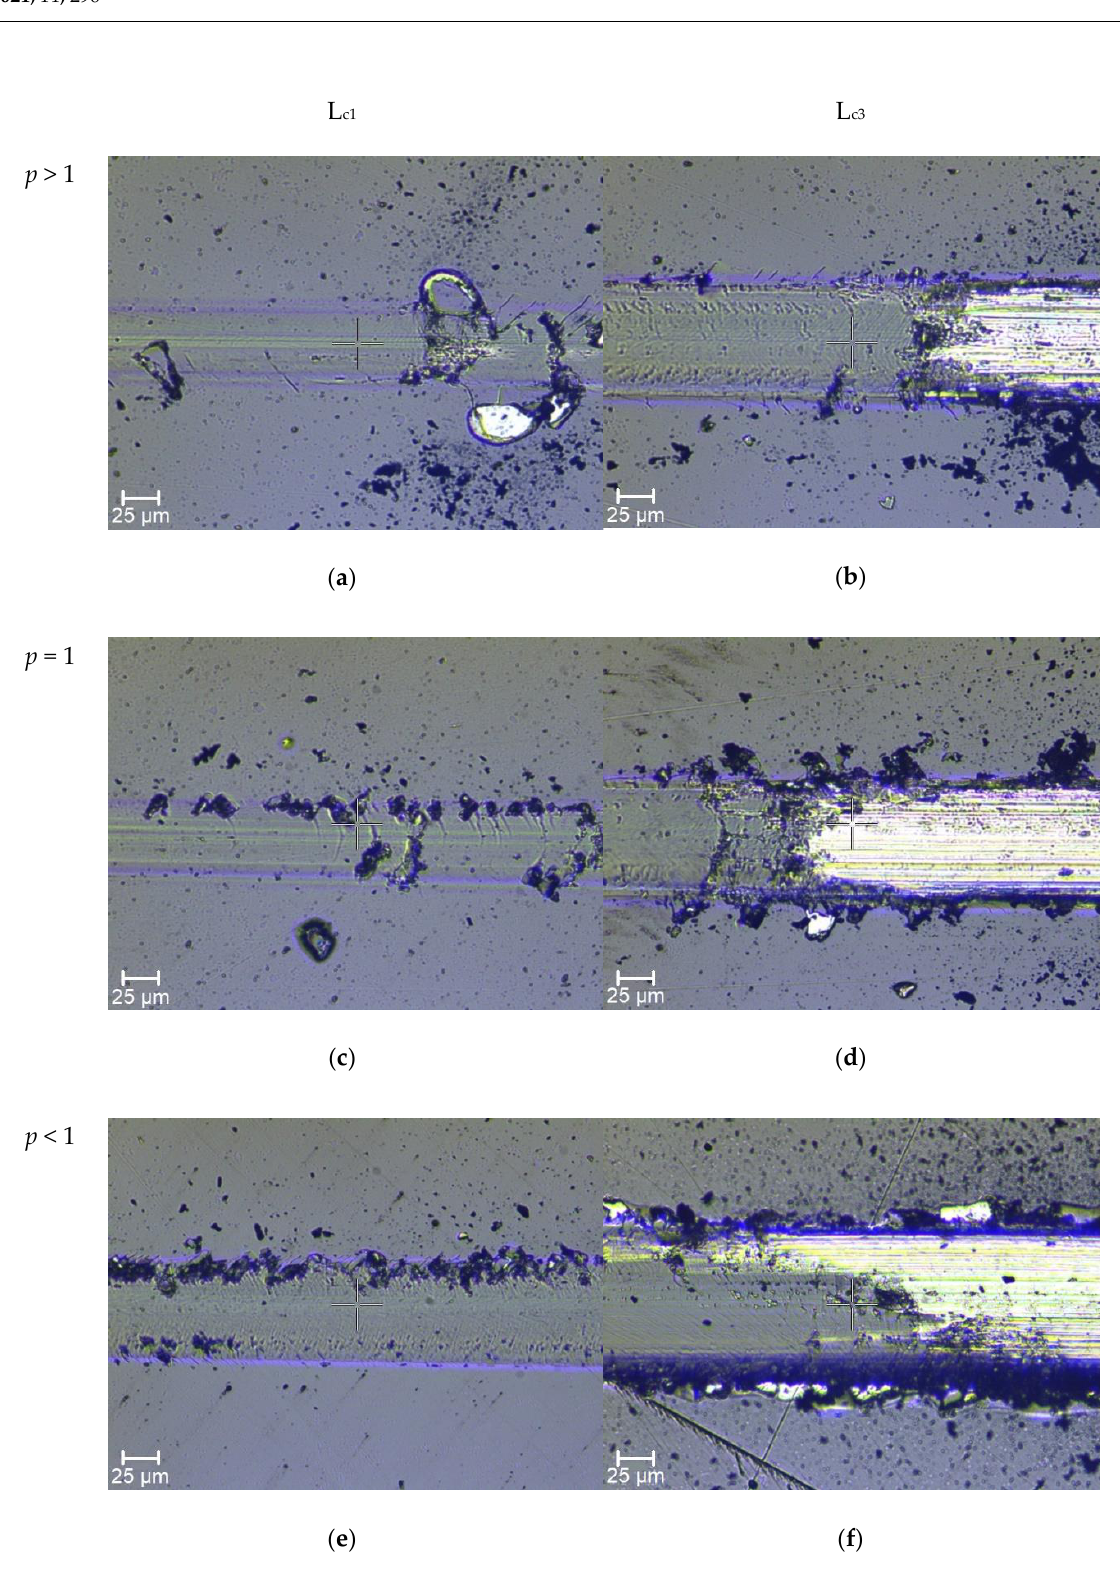
Figure 11. Microscopic photos of scratches for selected prototypes: p > 1 ( a , b ), p = 1 ( c , d ), p < 1, ( e , f ). Damages occurring in the scratch path for the coating with the value of p > 1 (hardness H = 25 GPa, with a depth of 0.15 µ m) are typical damages of hard brittle coatings (belonging to the group of brittle failure modes in scratch testing) deposited on high-hardness substrates, in this case, an HS -6-5-2 steel substrate with a hardness of H = 8 GPa. The first cracks in the coating (L c1 = 13 N), the so-called Chevron (angular) cracks, belong to